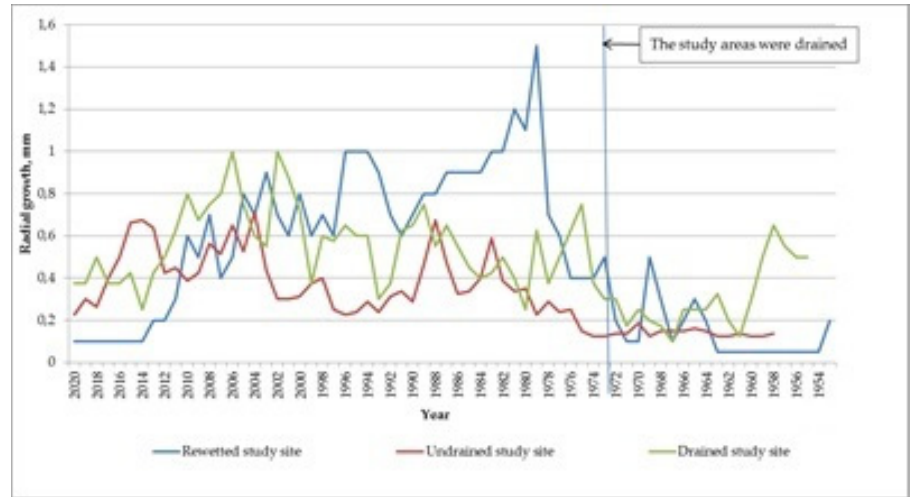
Figure 4. Dynamics of the absolute values of the annual radial growth of pine on the study sites.